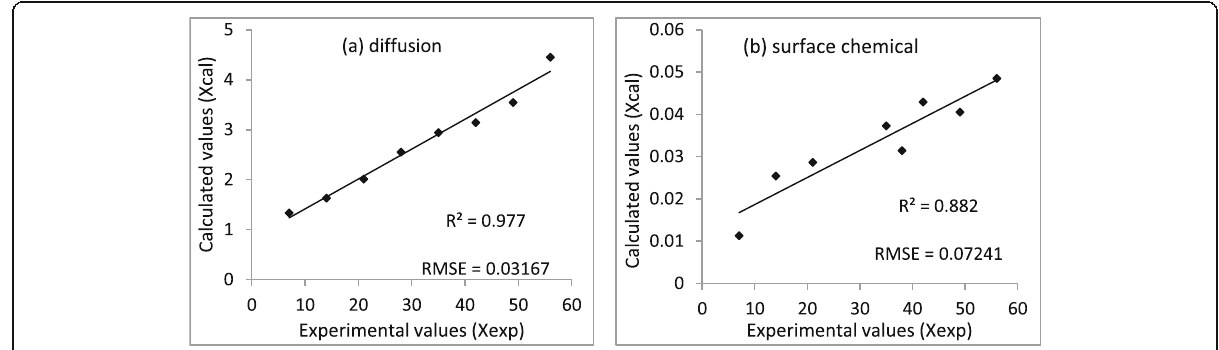
Fig. 11 a , b Correlations between experimental and calculated conversion values